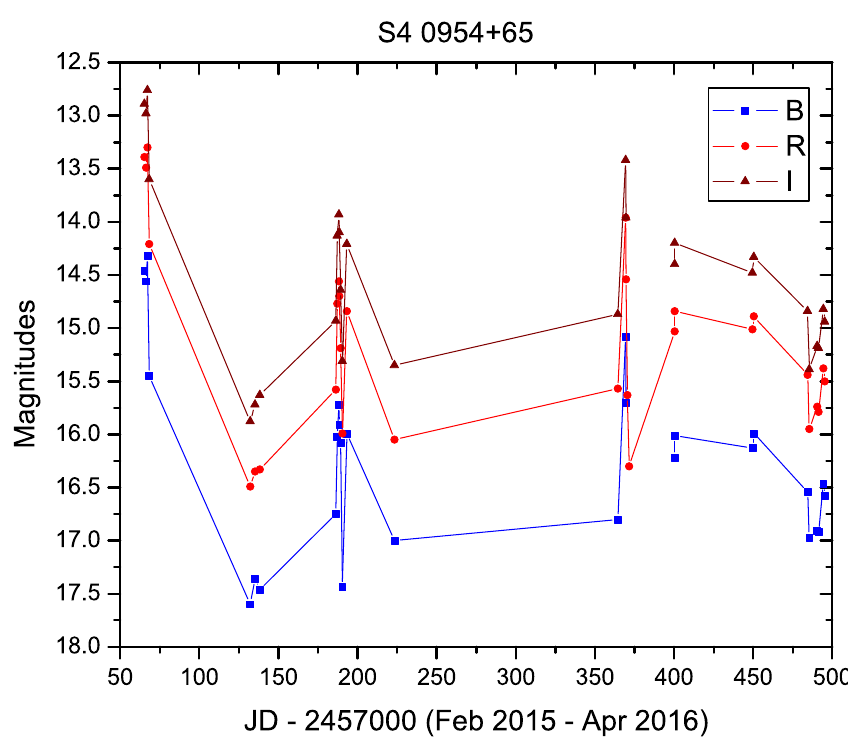
Figure 1. Long-term behavior of S4 0954+65 for the observed period (February 2015–April 2016). Changes of up to 3 mag are seen for a relatively short period of time.